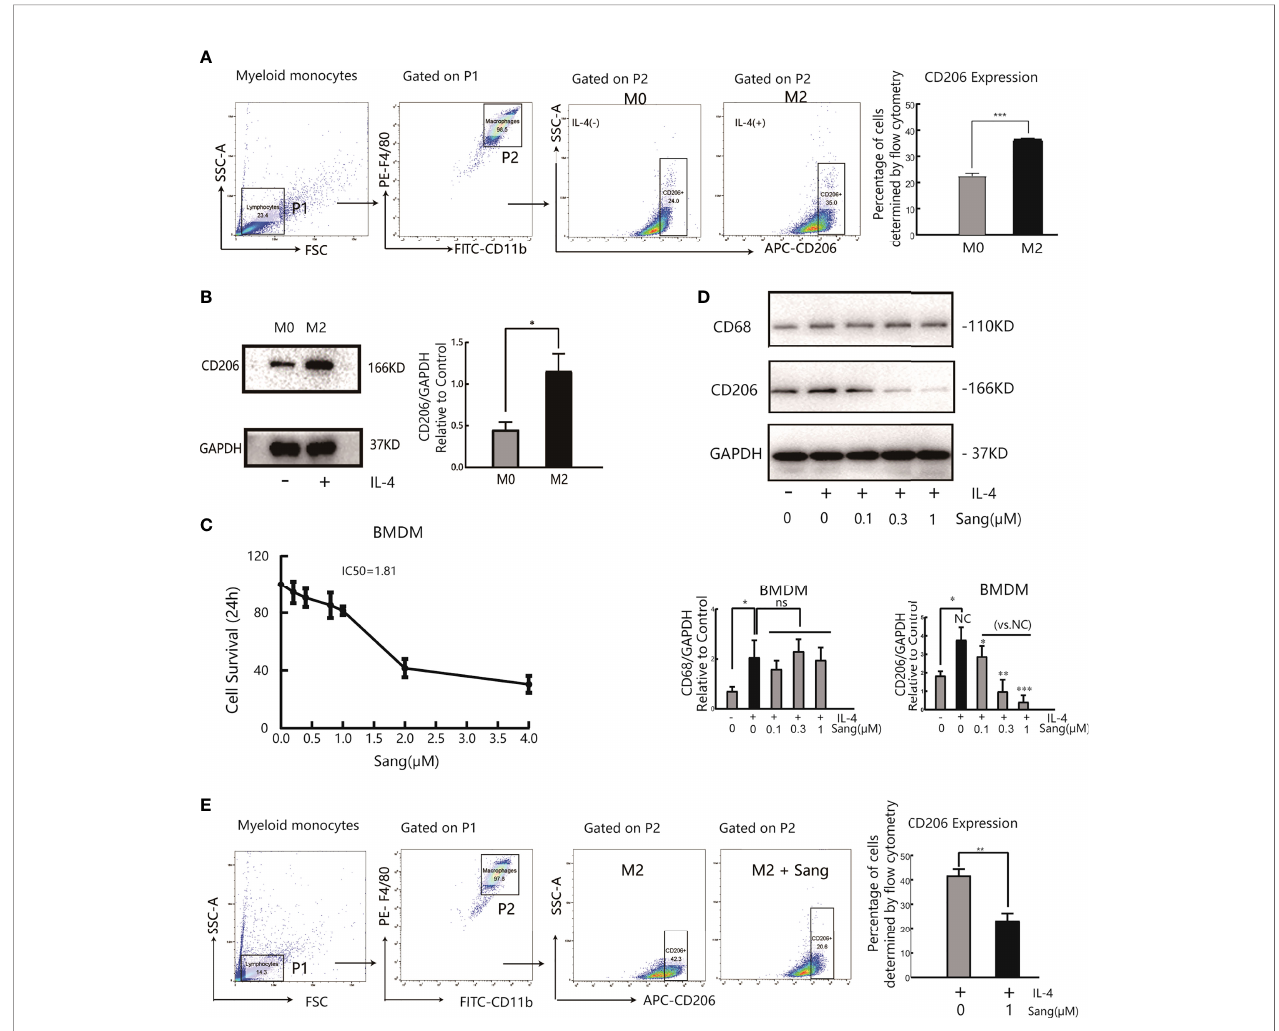
FIGURE 2 | Sang suppresses M2 polarization in macrophages. Bone marrow-derived macrophages (BMDMs) were isolated from mice and treated with IL-4 (20 ng/ ml) for 24 h for M2 polarization. (A) Flow cytometry analysis of the expression of the M2-like macrophage surface marker CD206. (B) Western blot analysis of CD206 protein expression in IL-4- stimulated BMDMs. (C) BMDMs were incubated in the presence of Sang at different concentrations (0, 0.2, 0.4, 0.8, 1, 2, and 4 µM) for 24 h, and cell viability was determined by the CCK-8 assay. (D) BMDMs in the presence or absence of IL-4 were treated with different concentrations of Sang (0.1, 0.3, and 1 µM), and the expression of CD68 and CD206 proteins was detected through a western blot assay. (E) Flow cytometry detection of CD206 expression treated with 1 µM Sang Each experiment was reproduced three times. * p < 0.05; ** p < 0.01; *** p < 0.001; ns, not statistically signi fi cant ( p >